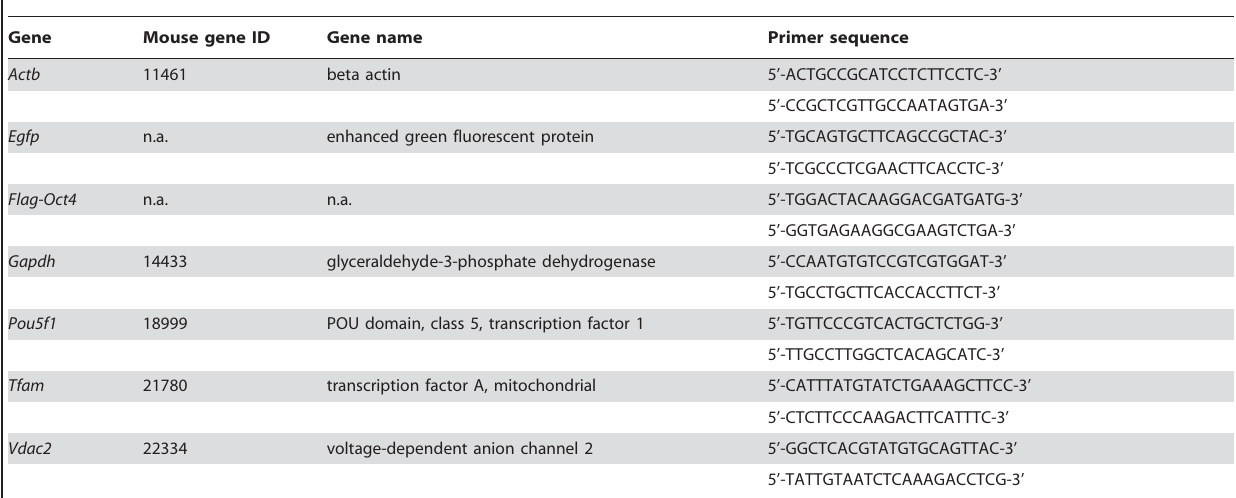
Table 3. Primer sequences for SYBR green